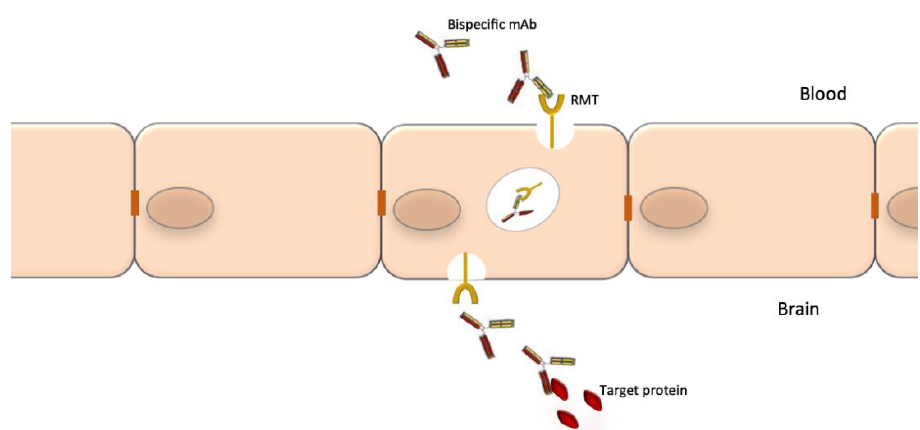
Figure 3. Crossing of the blood-brain barrier by specifically engineered bispecific mAbs. The blood-brain barrier (BBB) is an obstacle for the delivery of mAbs to the CNS. Bispecific mAbs may be used to cross the BBB as through their one specificity they can be shuttled via receptor-mediated transport (RMT), while the other can be used to bind the target proteins.